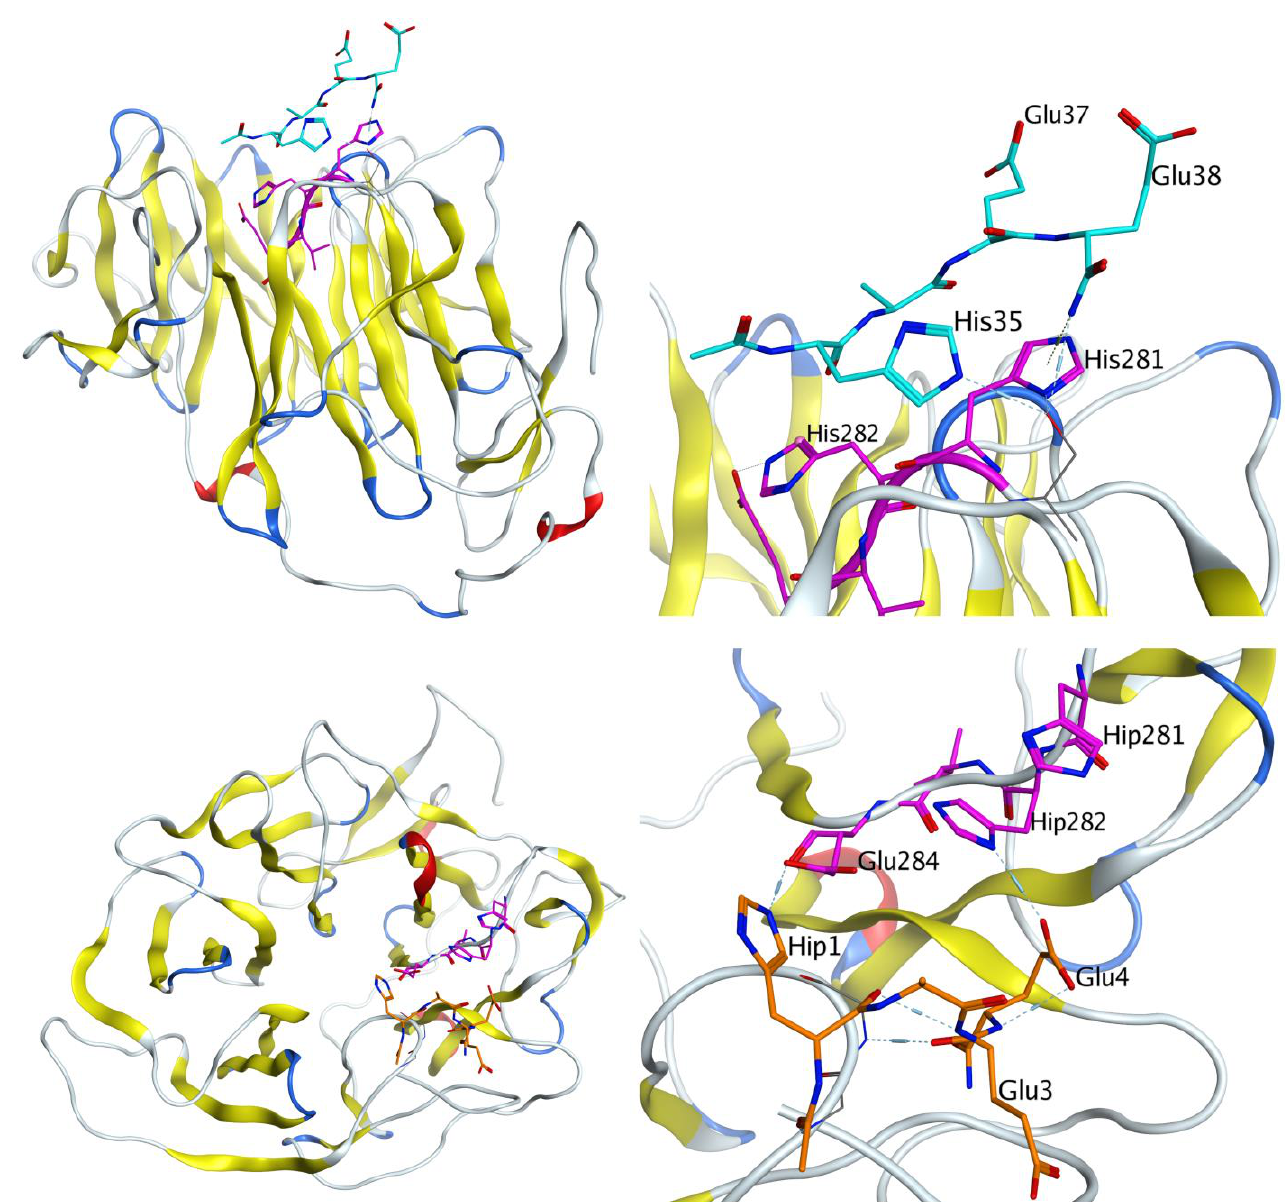
Figure 4. Interaction of the HAEE tetrapeptide (marked blue for the unprotonated system, marked orange for the protonated system) with the 281-HHVE-284 site (marked pink) of LRP1 after 50 ns (top) and 20 ns (bottom) of MD equilibration.